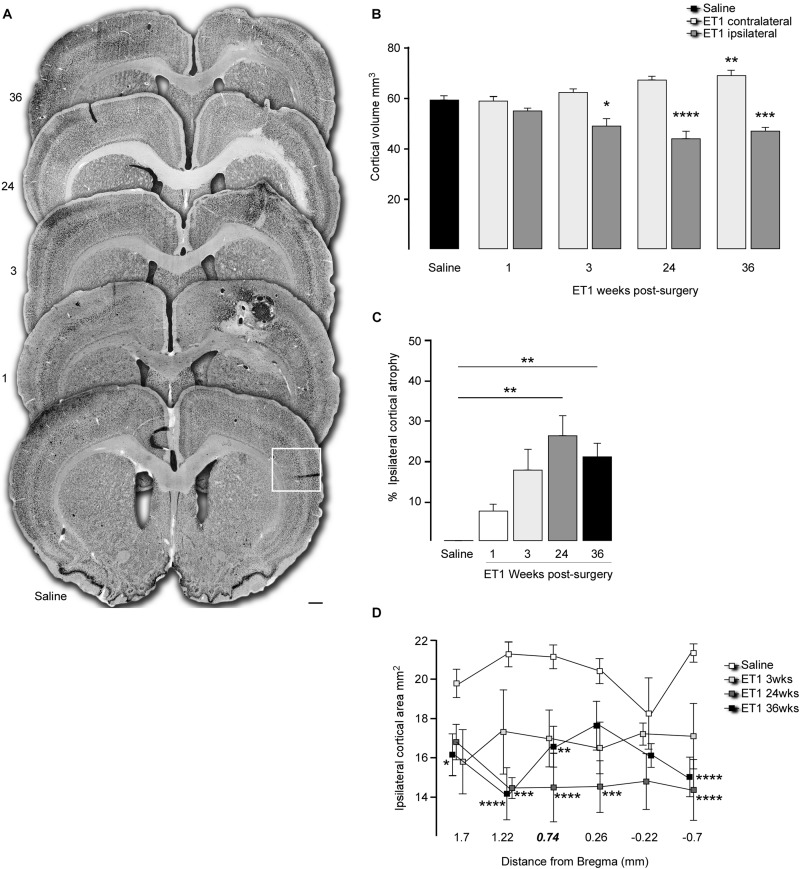
Progressive cortical atrophy after focal ischemia. (A) Representative coronal sections labeled for NeuN illustrate gross morphology for a saline injected animal and 1, 3, 24, and 36 weeks after ET-1 injection (note enlarged versions of the boxed area are illustrated in Figure 3). (B) Total hemispheric cortical volume (bregma –2.1 to +2.7) in saline injected animals (n = 8, pooled data for contralateral and ipsilateral hemispheres shown) and ET-1 animals 1 (n = 4), 3 (n = 4), 24 (n = 5) and 36 (n = 8) weeks after ET-1 injection, showing a significant loss of volume in the ipsilateral cortex at 24 and 36 weeks (one way ANOVA, F8,41 = 16.87, p < 0.001 with Dunnett’s multiple comparisons tests; ∗p = 0.0177; ∗∗p = 0.0046; ∗∗∗p = 0.0003; ****p = 0.0001). (C) Progression of ipsilateral cortical atrophy over time, expressed as% atrophy relative to saline treated animals, shows significant atrophy at 24 and 36 weeks (one-way ANOVA F4,20 = 5.65, p = 0.0033, Dunnet’s multiple comparison test; ∗∗p < 0.01). (D) Ipsilateral cortical area at specific rostra-caudal levels shows that compared to saline injected animals there was a significant reduction in area initially closest to the ET-1 injection site and then extending to more distal rostro-caudal levels at later time-points [two-way ANOVA with a significance with time F4,144 = 28.83, p < 0.0001; saline (n = 8), ET-1 3 weeks (n = 4), ET-1 24 weeks (n = 5), ET-1 36 weeks (n = 8); ∗p < 0.05; ∗∗p < 0.01; ∗∗∗p < 0.001; ****p < 0.001]. All data shown as the group mean ± SEM. Scale bar: (A) 500 μm.